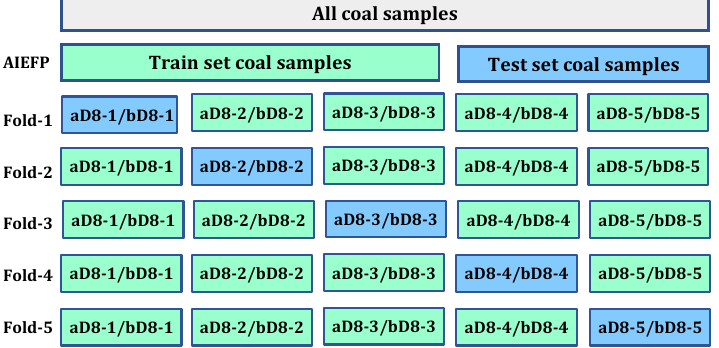
Figure 8. Coal samples of the train set and test set of five-fold cross-validation.